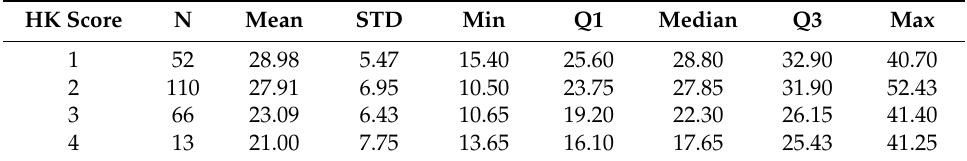
Table 1. The sample size (N), the mean values (Mean), the standard deviation (STD), the minimum (Min), the 25%-quantile (Q1), the median (Median), the 75%-quantile (Q3), and the maximum (Max) of the measured dielectric constant values per hyperkeratosis-score (HK Score).